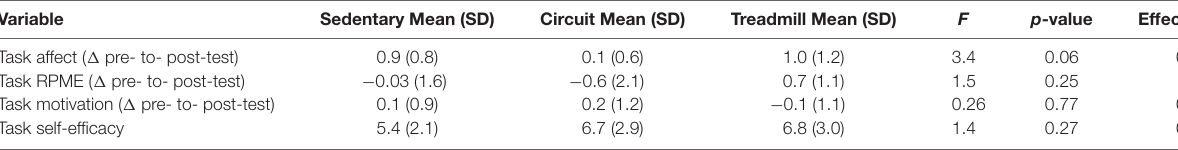
TABLE 2 | Change in secondary outcomes by condition.